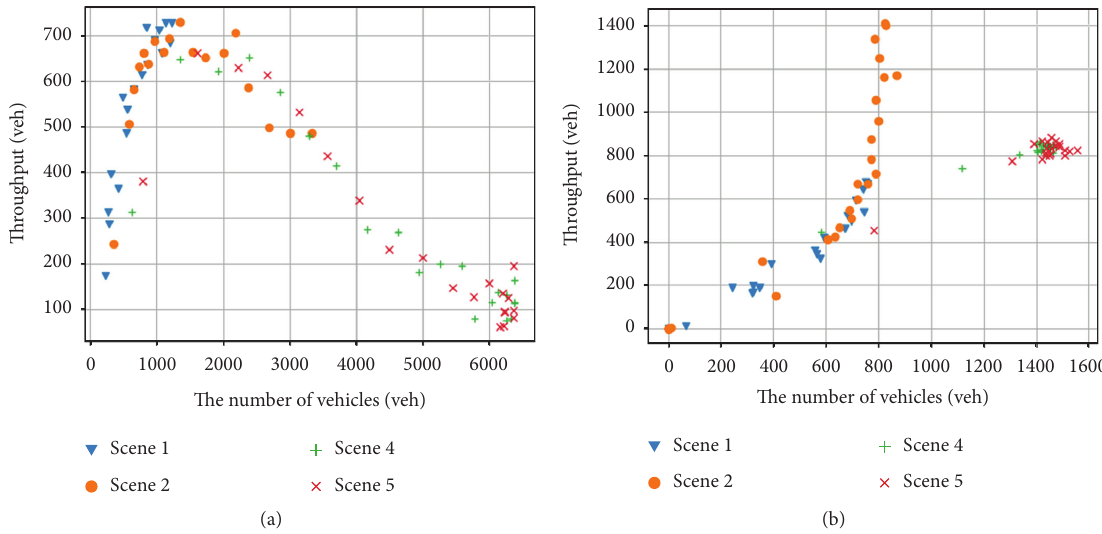
Figure 11: The throughput of a 4 × 4 network with one strategy and fixed phasing time for scenarios 1, 2, 4, and 5. By comparing the results with Figure 10, it can clearly be seen that the proposed method is more efficient than the results of Yan et al. [45]. It is also able to control the traffic in very heavy traffic like scenarios 4 and 5. (a) Fixed time traffic light. (b) The proposed traffic light phasing without